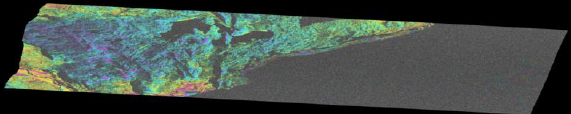
Figure 8. Ascending track-Sept.10-21: Points after filtration and thresholding, (Hlaváčová, 2015)